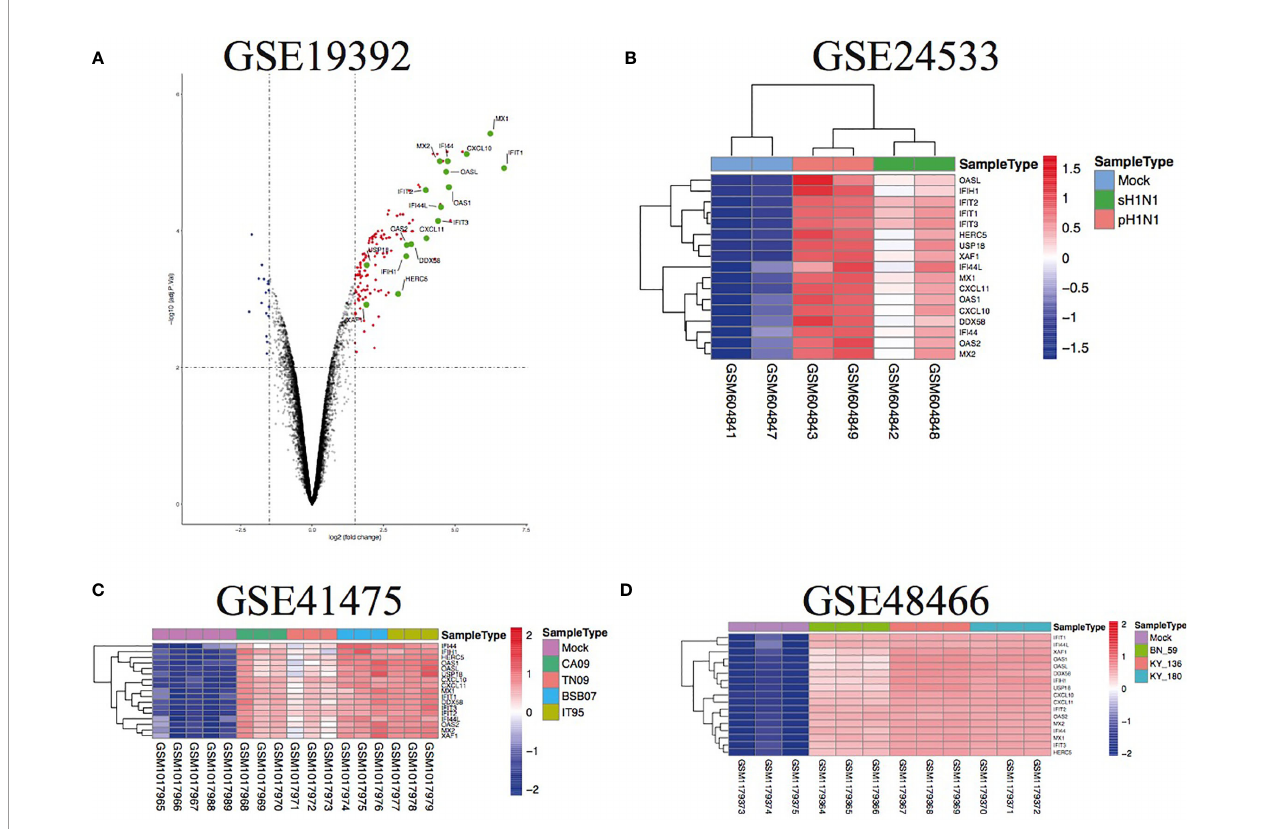
FIGURE 5 | The overlap regulation gene expression of diverse primary epithelial cells in response to H1N1 infection. (A) Volcano plots of the overlaps between mock and H1N1-infected human bronchial epithelial cells. The vertical dashed lines correspond to 1.5-fold up and down expression and the horizontal dashed line represents a p -value of 0.01. Blue and red dots indicate signi fi cantly downregulated and upregulated genes, respectively. The 17 overlapped genes identi fi ed in different IAV subtype infections are exhibited in the Volcano plots. (B) Heatmap of the overlaps in mock or H1N1-infected human type I-like alveolar epithelial cells. Row represents the overlap genes and each column corresponds to a sample; (C) heatmap of the overlaps in mock or H1N1-infected primary human airway epithelial cells. Row represents the overlap genes and each column corresponds to a sample; (D) heatmap of the overlaps in mock or H1N1-infected well- differentiated primary human bronchial epithelial cells. Row represents the overlap genes and each column corresponds to a